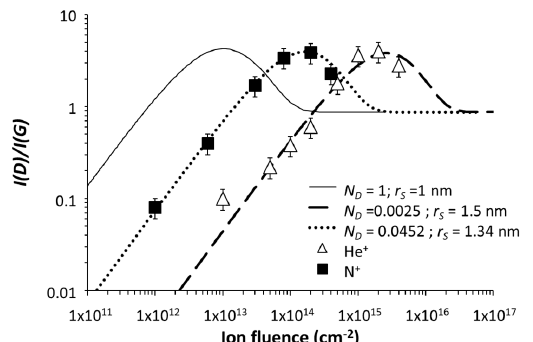
Figure 3. Ratio of intensities of Raman lines I ( D )/ I ( G ) versus ion fluence for graphene on 6H–SiC (0001) bombarded with nitrogen ions (squares) and helium ions (triangles). Solid line represents theoretical curve of I ( D )/ I ( G ) vs. ion fluence according to [18] for N D = 1 and r S = 1 nm. Dotted and dashed lines represent theoretical dependence of I ( D )/ I ( G ) for r S = 1.34 nm and r S = 1.5 nm and ion defect efficiencies N D = 0.045 and 0.0025 for N + and He + respectively.